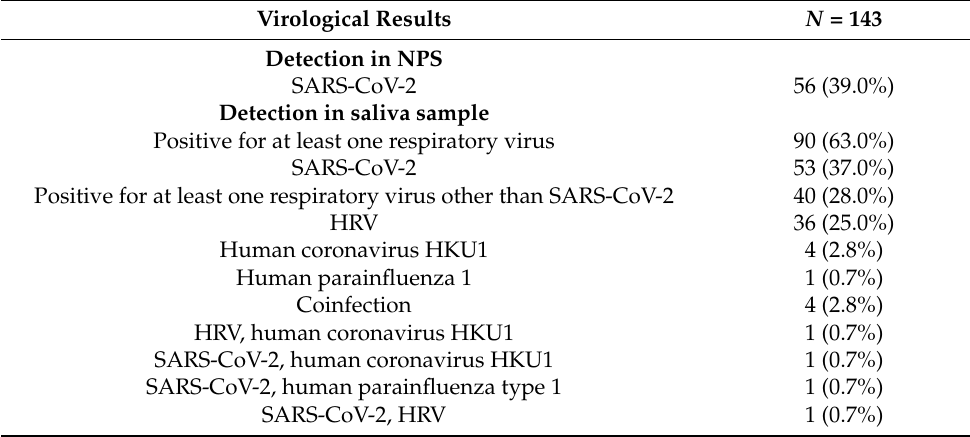
Table 3. Results of SARS-CoV-2 detection in NPS and saliva samples collected from patients with ARI. NPS Total Positive Negative Positive 51 (96.2%) 2 (3.8%) 53 (100%) Saliva sample Negative 5 (5.6%)